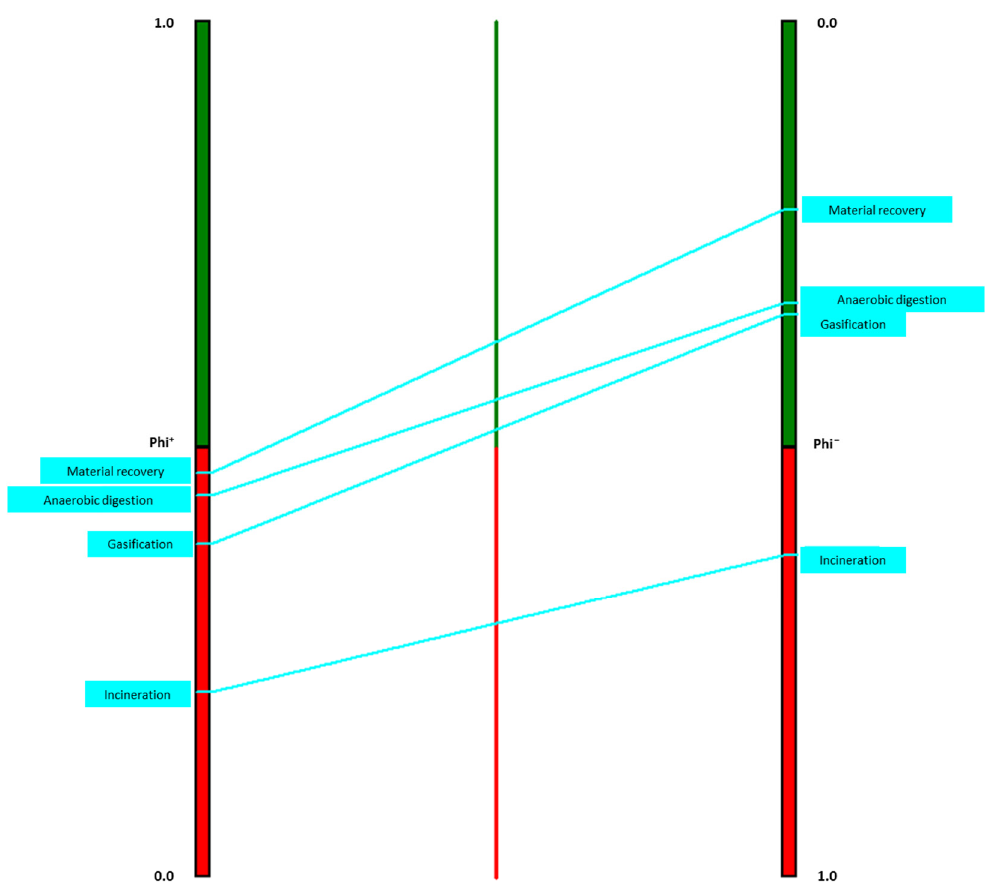
Figure 4. The PROMETHEE I partial ranking of sewage sludge treatment technologies.